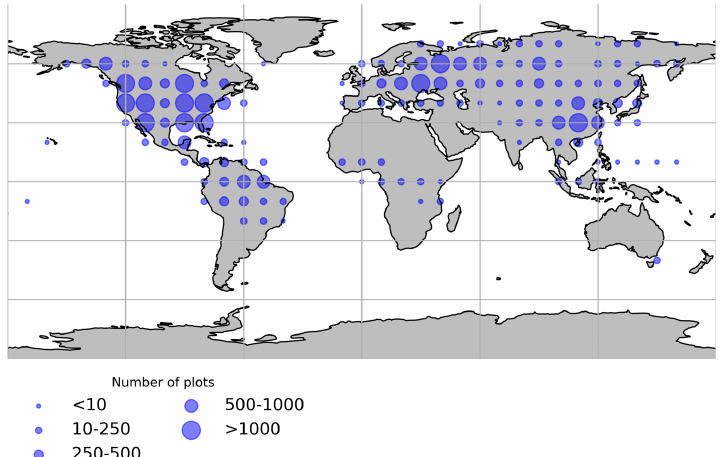
Figure 1. Spatial distribution of the forest inventory plots used for the forest age maps. Each dot represents the total number of plots within 10 ◦ × 10 ◦ .